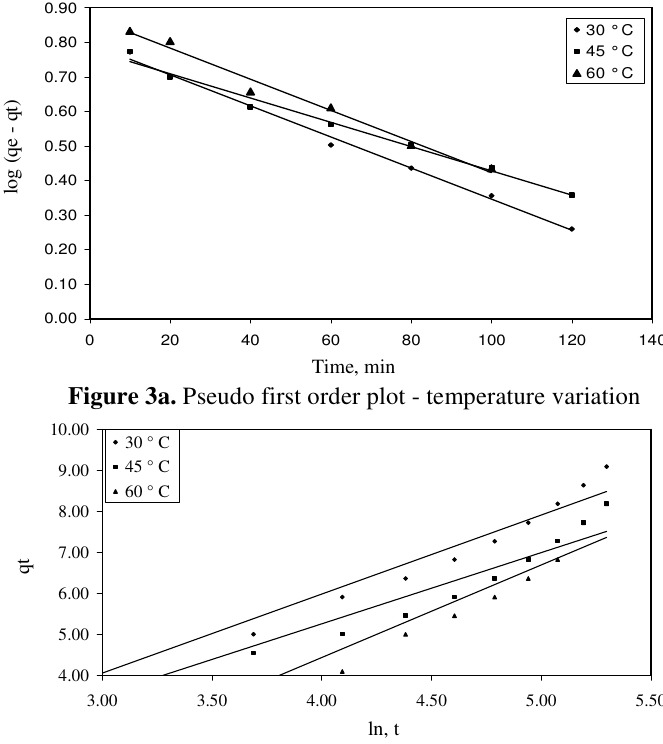
Figure 3b. Elovich plot - temperature